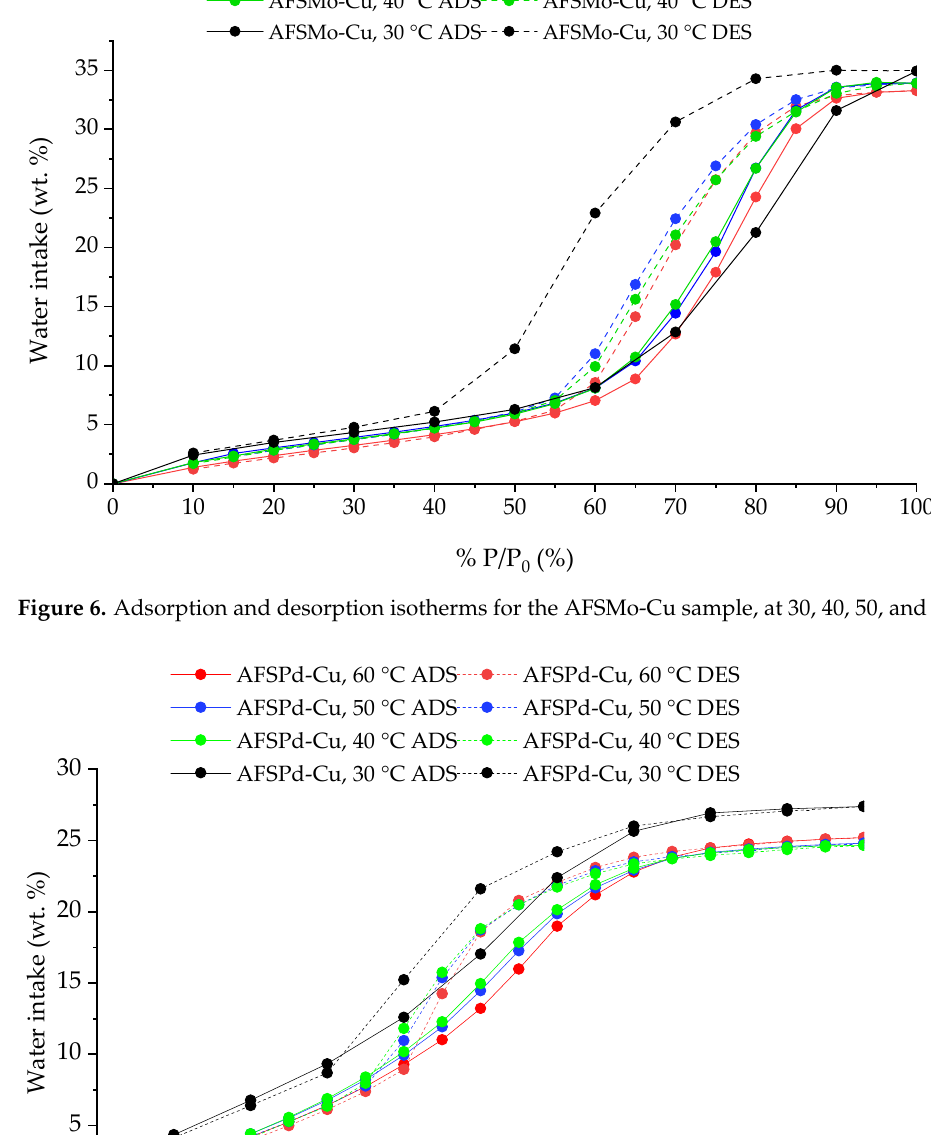
8 of 16 Figure 5. Thermal diffusivity coefficient of selected samples measured at four process temperatures (30, 40, 50, 60 °C) . The highest thermal diffusivity coefficient was measured for the MPSilica sample— about 0.3 mm 2 /s, while the lowest was measured for silica gel—about 0.2 mm 2 /s for both samples. The interesting thing is that the tested sorbents were characterised by a stable